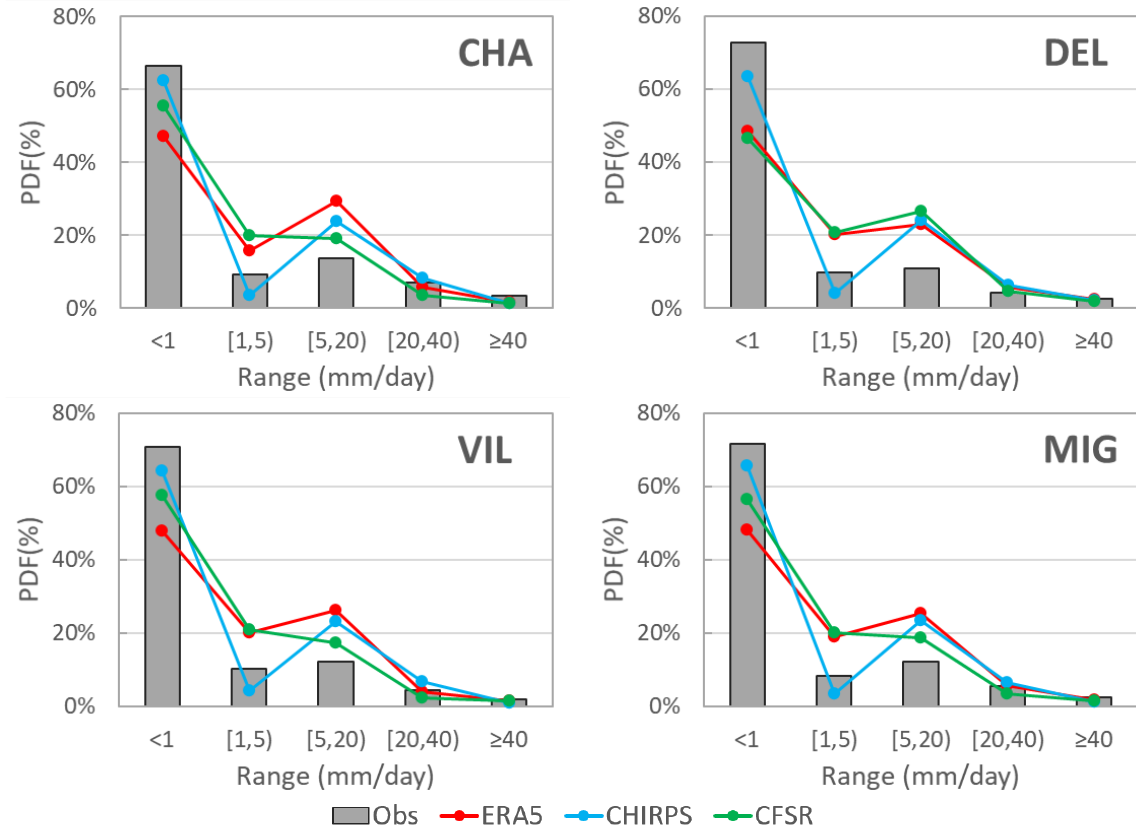
Figure 3. Description of different rainfall intensities of the probability density function of rainfall events on a daily scale.